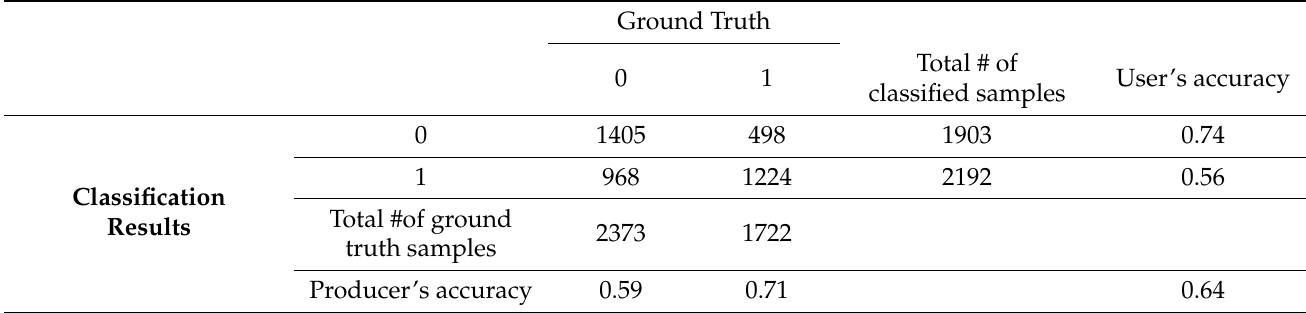
Table 5. Confusion Matrix for X. fastidiosa subsp. pauca severity classes using the quadratic discriminant classification with the absolute counts and the accuracies.